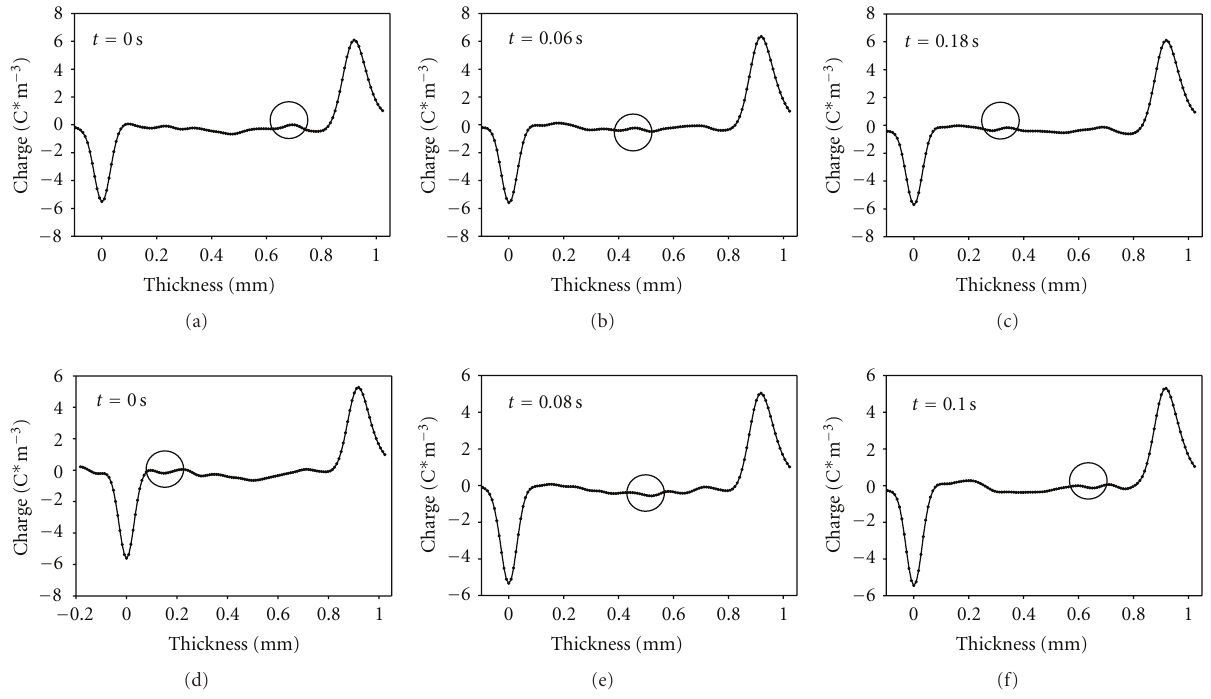
Figure 4: Evolution of charge profiles in specimen no. 1 under an electrical field of 10 kV/mm and temperature of 70 ◦ C for a positive charge pulse (a)–(c) and a negative charge pulse